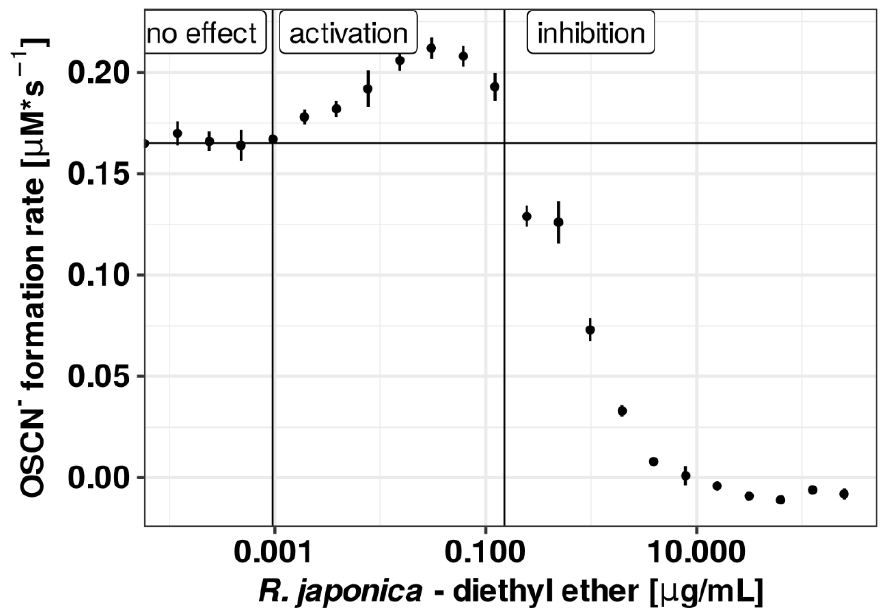
Figure 3. The dependence curve of observed OSCN – formation rate in the presence of successive dilutions of the studied extract showing both inhibitory and activating effects (extract of diethyl ether fraction from R. japonica ).